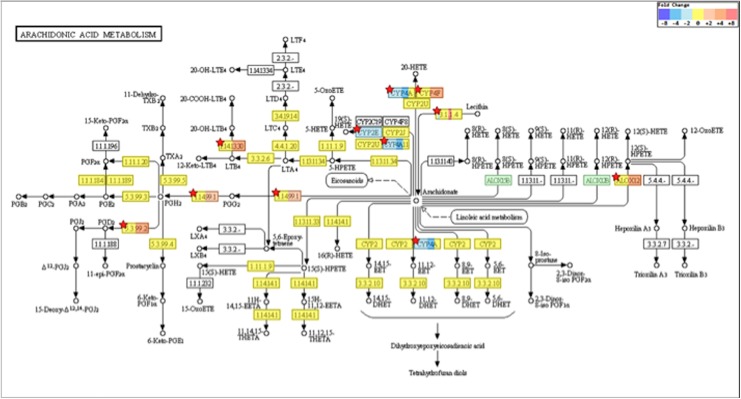
Change in the arachidonic acid metabolism pathway (KEGG map ID: mmu00590) based on the differentially expressed genes in bronchial smooth muscle tissues of the antigen-challenged mice. Total RNA sample of each mouse (4 animals, respectively) was subjected to the microarray analysis, and Kyoto Encyclopedia of Genes and Genomes pathway analysis of differentially expressed genes was performed. Enzymatic reactions are marked by arrows. Fold change values of differentially expressed genes are shown in colors. Different colors in a box for the same module indicate various genes with differing expression. White boxes of pathway map indicate modules that are not relevant to the mouse. Green color boxes of pathway map indicate modules that are not mapped (the gene is in the pathway map but its expression was not shown in the present study). The pathway modules containing differentially expressed genes with statistical significance are marked with red stars.